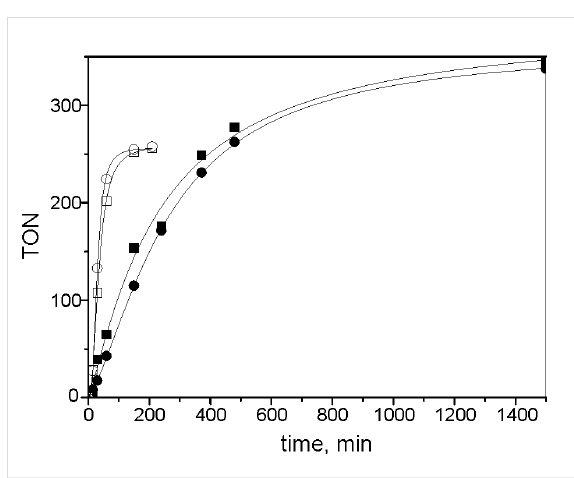
Figure 5: Metathesis of methyl oleate (open symbols) and methyl 10-undecenoate (filled symbols) with 3 /MCM-41 (circles) and 3 /SBA- 15 (squares). Molar ratio substrate /Ru = 500, T = 30 °C, c 0 substrate = 0.15 mol/L.